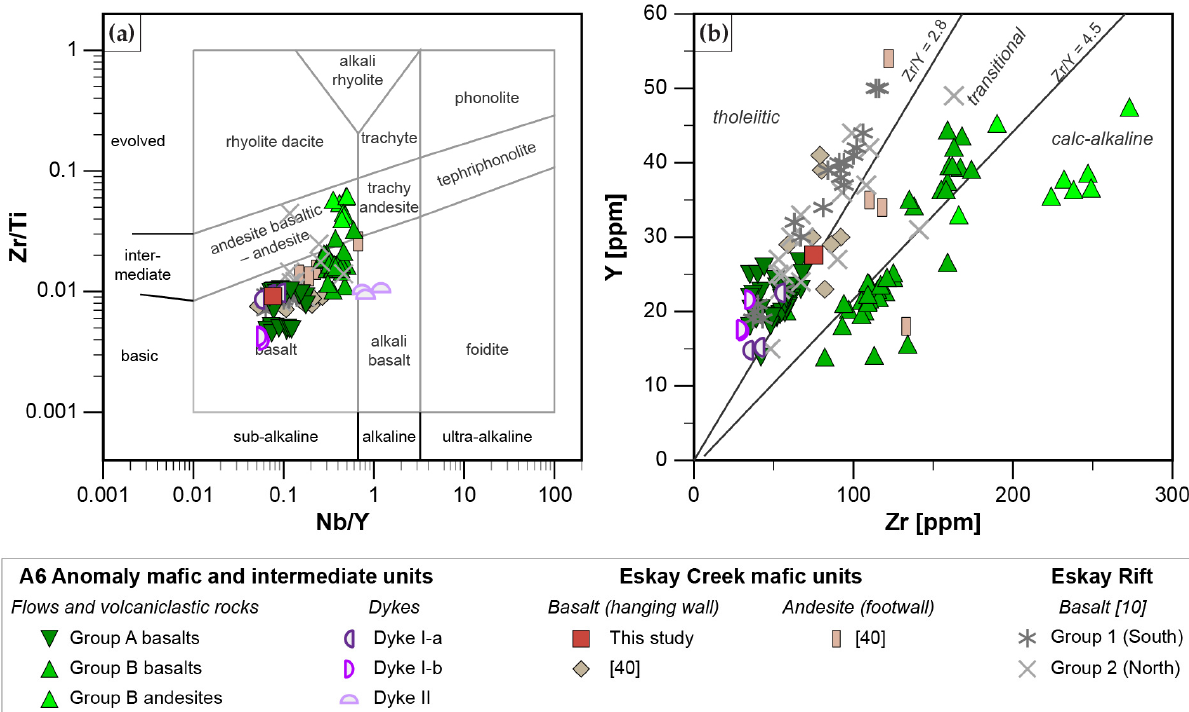
Figure 10. Rock classification and their magmatic affinity of mafic and intermediate igneous lithologies at the A6 Anomaly in comparison to samples from Eskay Creek (with data from [40] and this study) and basalts from the Eskay rift [10]. ( a ) Nb/Y vs. Zr/Ti classifying mafic and intermediate rocks from the A6 Anomaly and Eskay Creek, ( b ) Zr vs. Y characterizing magmatic affinity of mafic and intermediate lithologies. Rock classification diagram after [57], magmatic affinity for alkaline rocks using Zr/Y ratios of [53]. Note: Group A basalts from the A6 Anomaly and Group 1 basalts from the Eskay rift [10] are almost identical in their composition and hence overlap in particular in ( a ) resulting that data of Group 1 are partially obscured by Group A basalts since focus is on lithologies of the A6 Anomaly. The mafic and intermediate igneous rocks from the A6 Anomaly can be divided into basaltic flows with their volcaniclastic counterparts and dolerite dykes. Flows and volcan- iclastic rocks are further divided into: (1) Group A basalts, (2) Group B basalts, and (3) Group B andesites. This distinction is purely geochemically, since Group A and B basalts